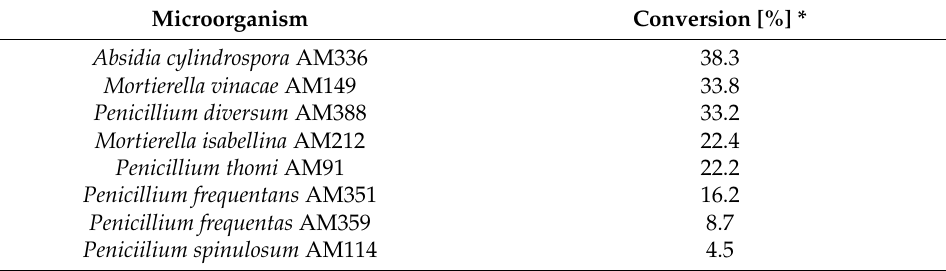
Table 4. Efficiency of 4 (cid:48) -hydroxywogonin ( 5 ) production by selected